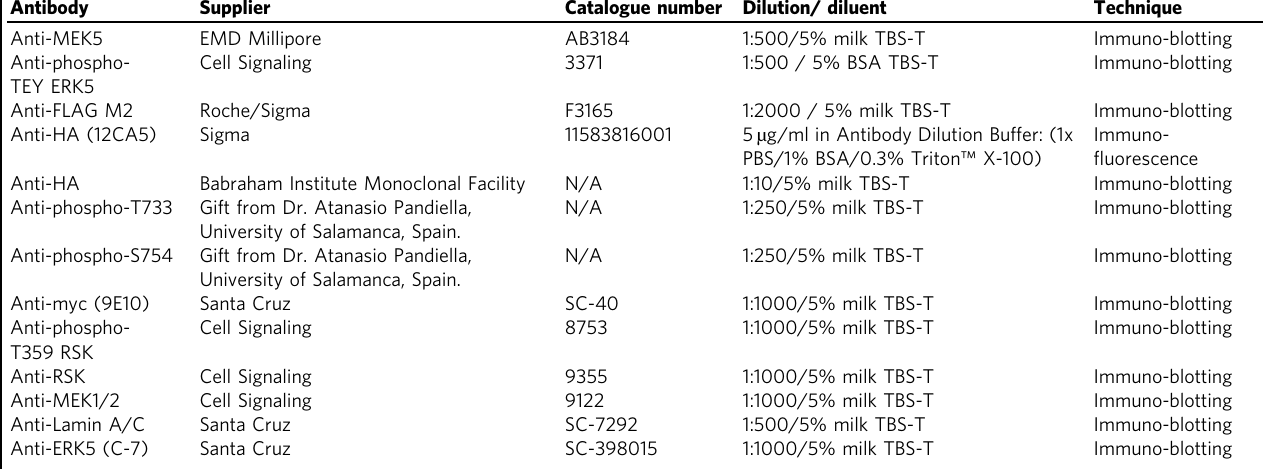
Table 1 Antibodies and conditions